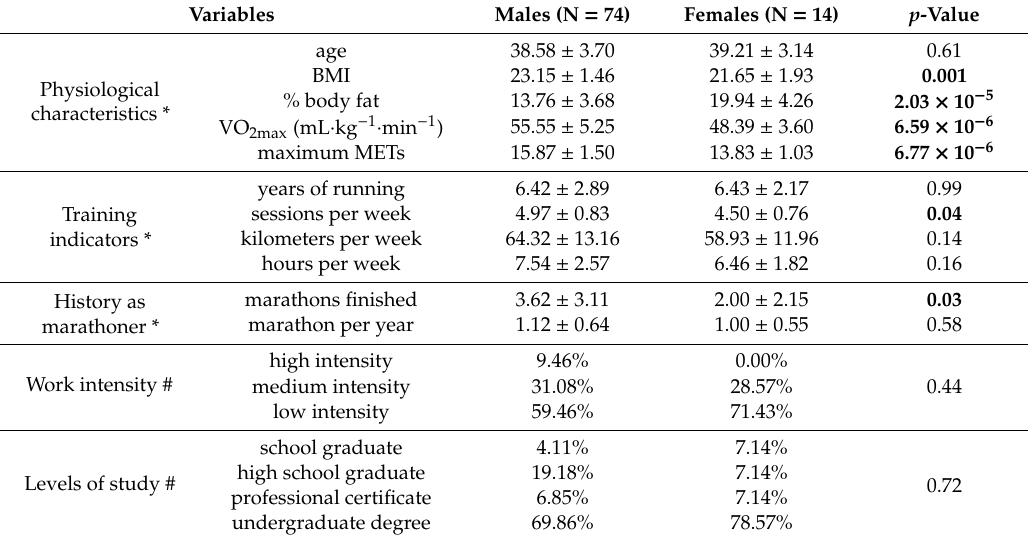
Table 2. Population description.